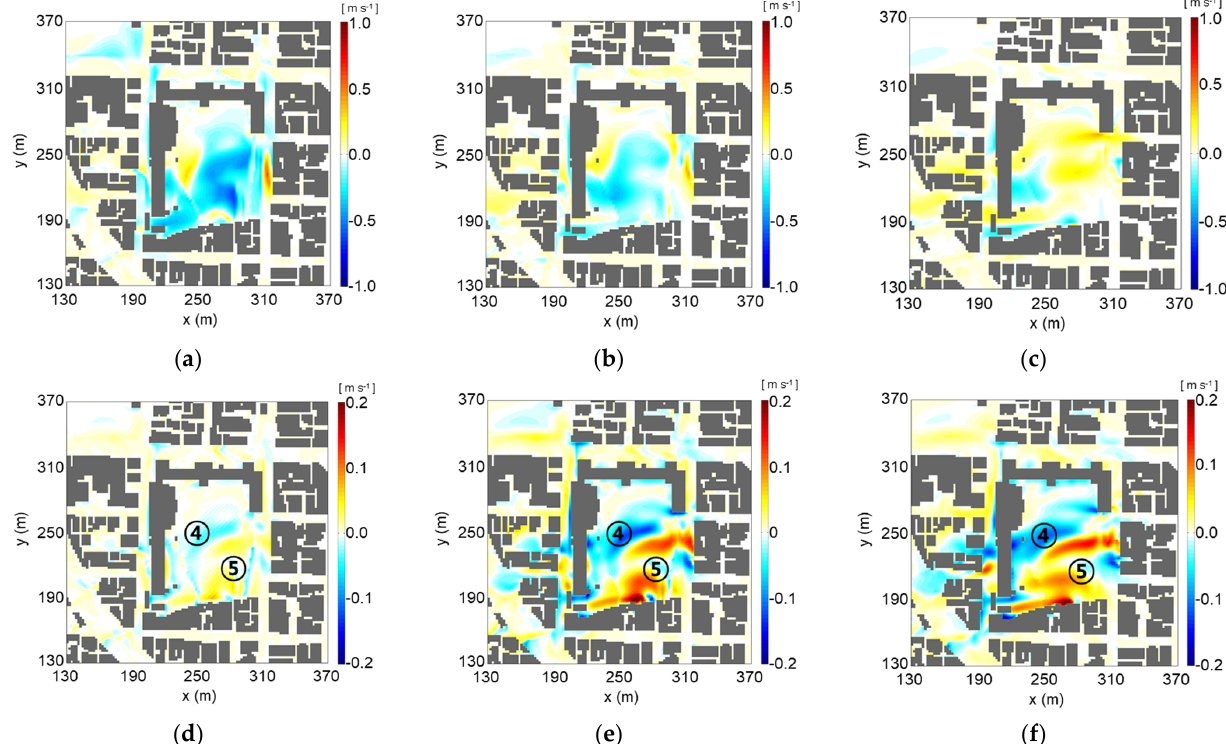
Figure 11. For the east–northeasterly inflow, the difference in the wind speed (upper panels) and vertical velocity (lower panels) of the T4M case compared to the CNTL case at 1 m ( a , d ), 5 m ( b , e ), and 9 m ( c , f ) above the ground.